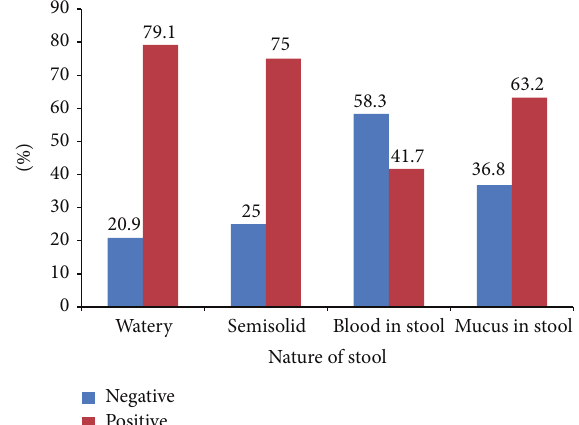
Figure 1: Distribution of rotavirus diarrhoea in children presenting with different types of stool in Sokoto.